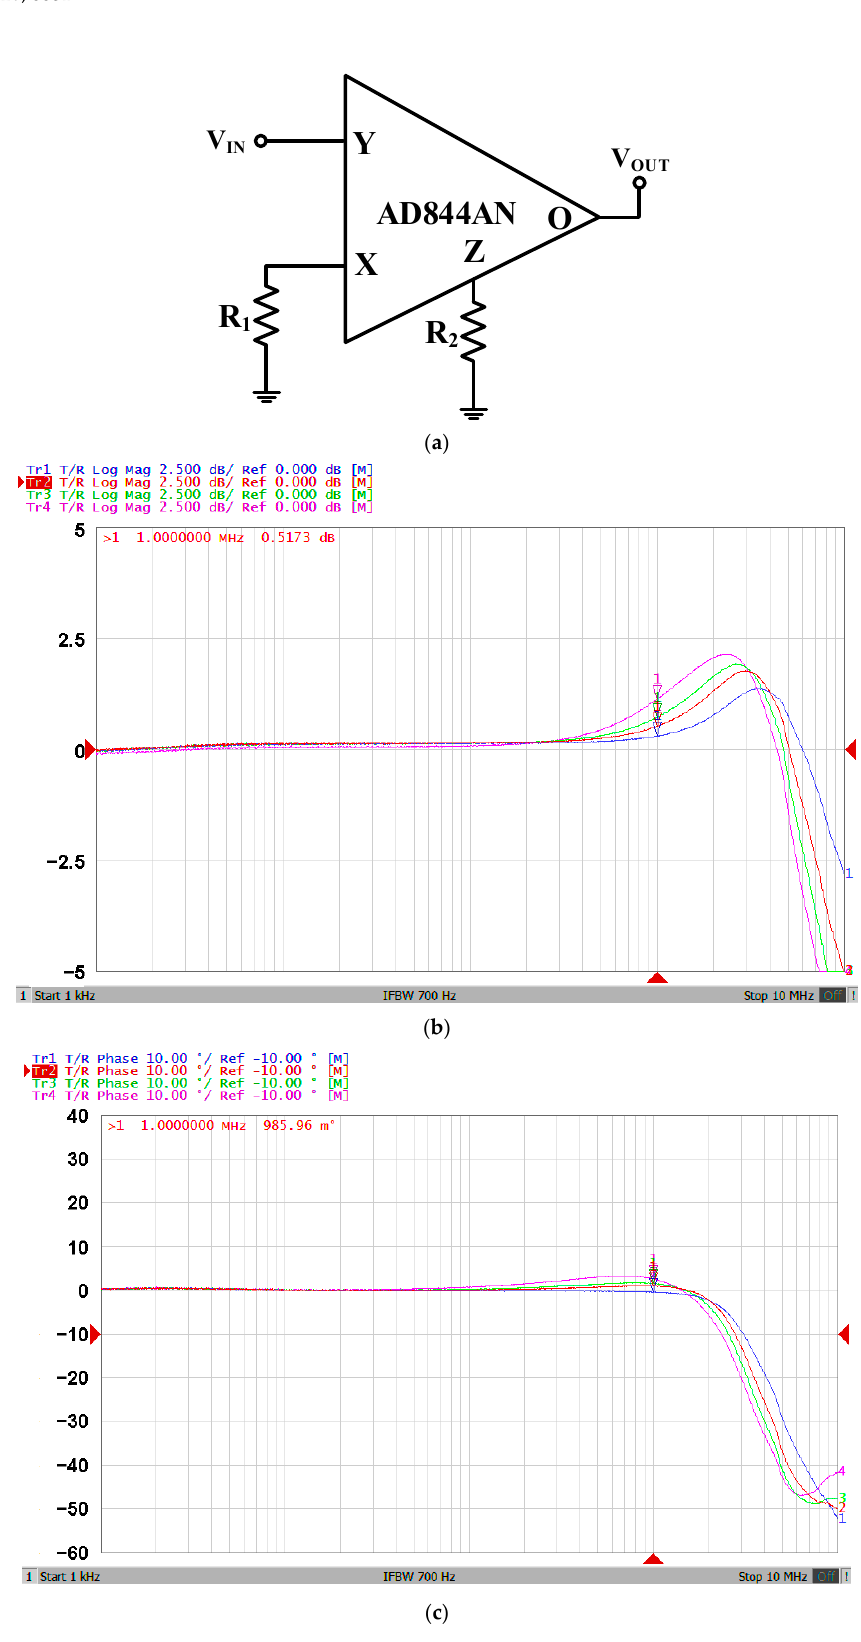
Figure 6. Experimental evidence of the frequency ranges of AD844AN with two equivalent resistances (R = 2 k Ω —blue line; R = 4 k Ω —red line; R = 6 k Ω —green line; and R = 10 k Ω —purple line). ( a ) Circuit diagram for testing gain and phase response frequency ranges of AD844AN; ( b ) measured gain responses of AD844AN; and ( c ) measured gain responses of AD844AN.